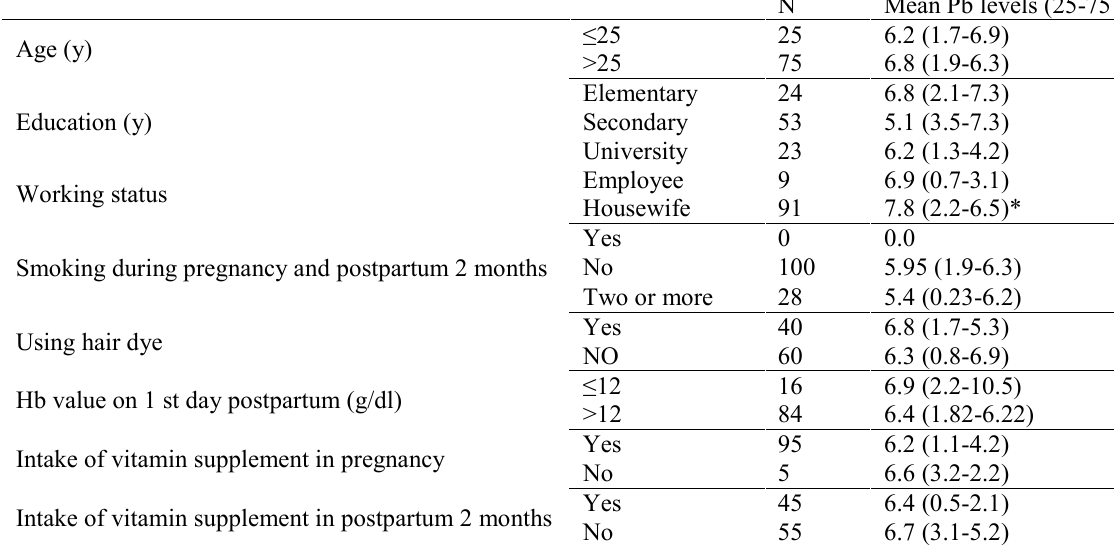
Table 2. Maternal sociodemographic characteristics related to Pb level in breast milk (